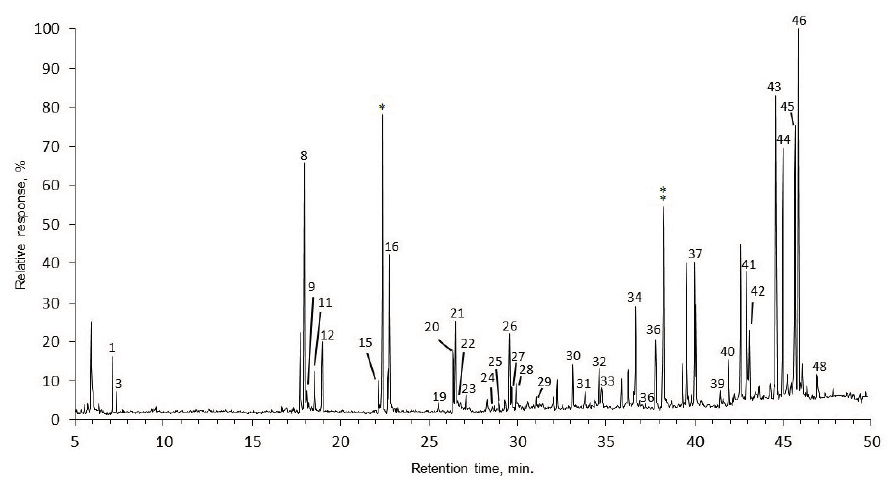
Figure 2. Gas chromatogram with mass-spectrometric detection of the total lipid extract of Rhytidiadelphus triquetrus (RT). IS, internal standard (* methylheptadecanoic acid, ** progesterone); numbers refer to the compounds listed in Table 1. Acid and alcohol groups were derivatized prior to the GC/MS